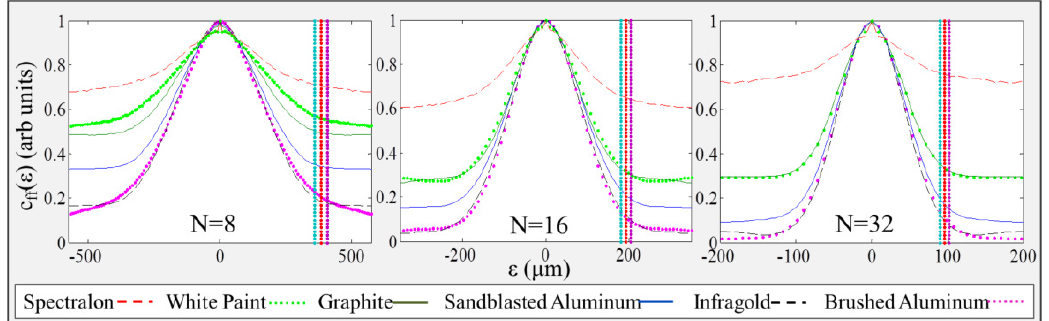
Figure 12. Autocorrelation for each reflector from N = 8 through N = 32. Red vertical lines mark the predicted spot size. The upper and lower bounds of the measured spot sizes are marked with vertical lines in cyan and magenta,